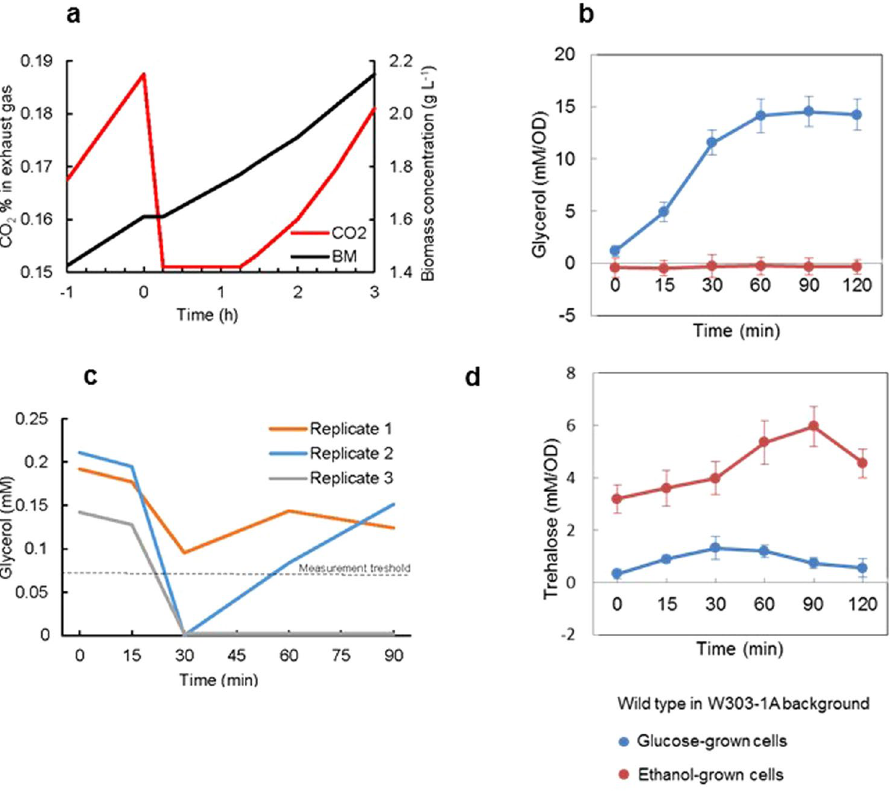
Figure 1. Growth parameter and intracellular glycerol and trehalose of wild type cells. ( a and c ) Bioreactor experiments. Time-dependent CO 2 , biomass ( a ) and glycerol ( c ) monitored in mineral medium with ethanol as the sole carbon source in response to 400 mM NaCl (final concentration) applied at timepoint 0 min. ( b and d ) Batch culture experiments. Cells were grown in complete YPD (glucose as a carbon source) or YPE (ethanol as a carbon source) medium and then stressed with 400 mM NaCl and ( b ) intracellular glycerol and ( d ) intracellular trehalose were monitored at the indicated time points. Values represent the mean and standard deviation of three